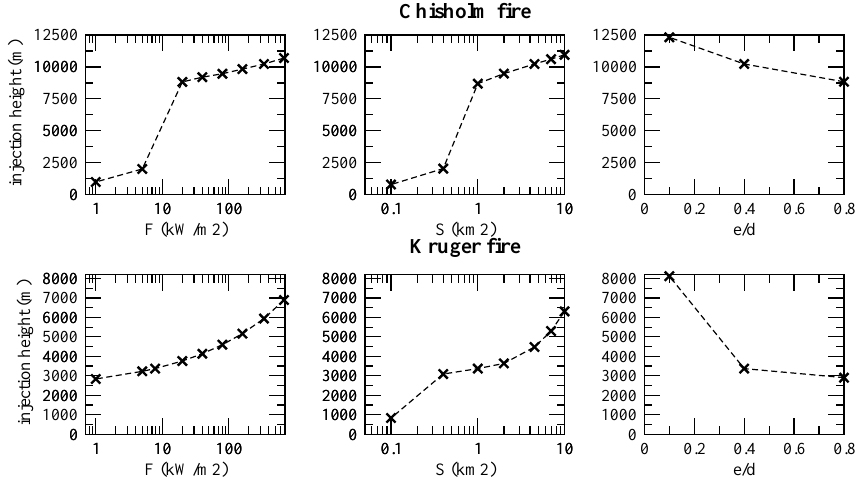
Fig. 6. Sensitivity of the injection height to the heat flux released ( F ), the active burning surface ( S ), and the ratio e/d for the Chisholm fire (top) and Kruger fire (bottom) conditions.